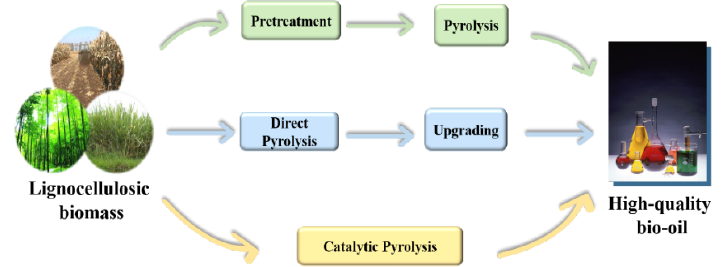
Figure 1. The three strategies for biomass pyrolytic conversion.